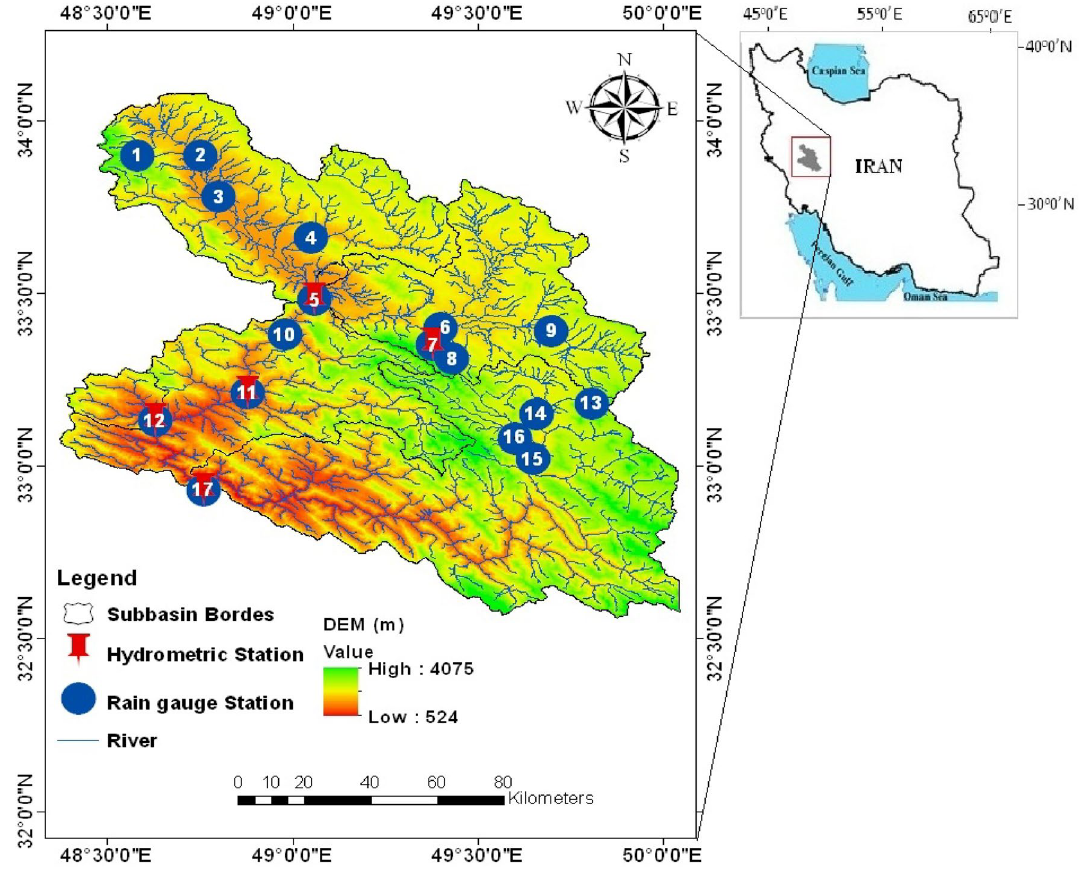
Figure 1. Location, topography, and stations of the Dez River Basin. This figure is created using version 10.2 of ArcGIS software (https:// www. arcgis. com).